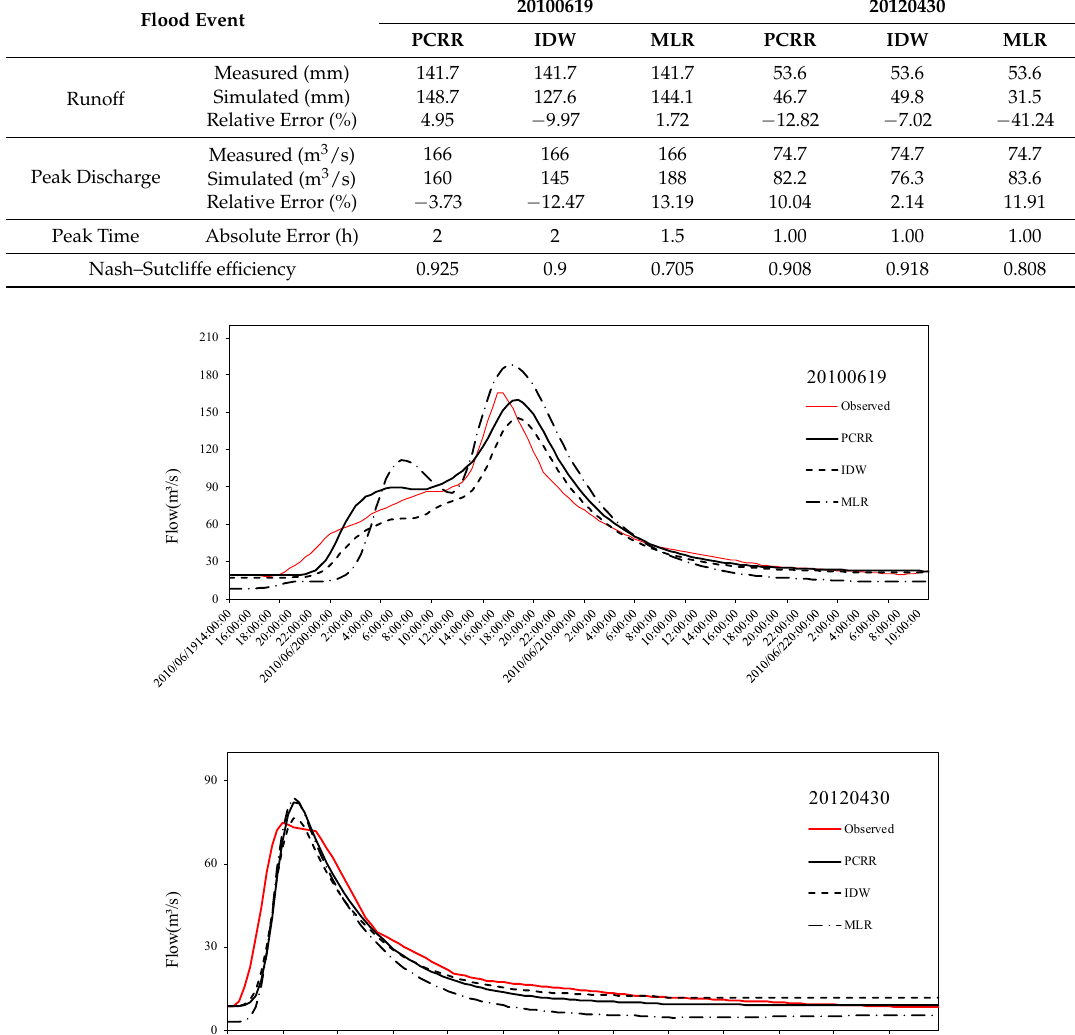
Table 10. Model performance of flood events using differently interpolated rainfall inputs.